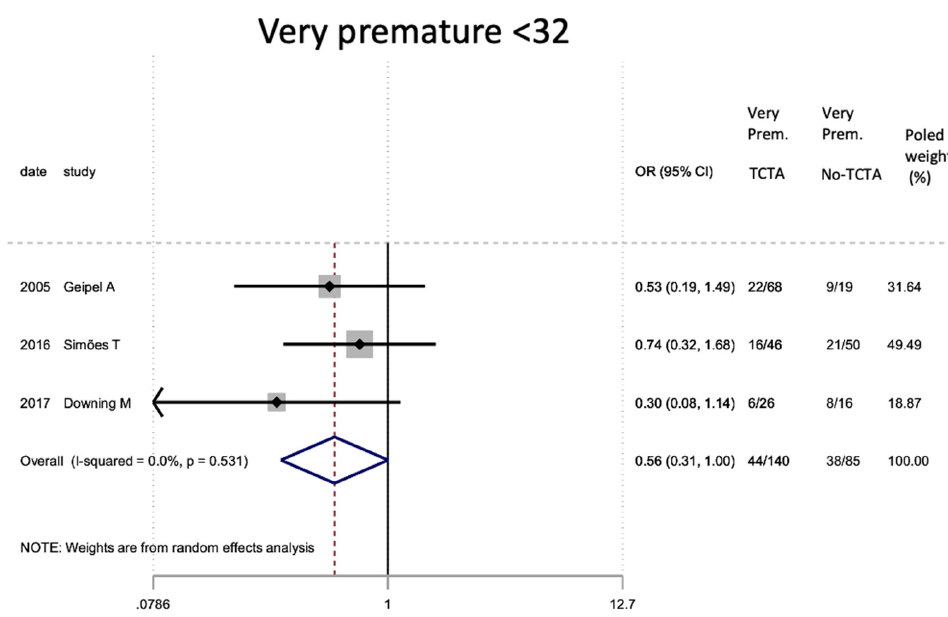
Figure 4. Results of the meta-analysis on the effect of chorionicity (TCTA vs no TCTA) on prematurity in newborns (under 37 weeks). Premat: prematurity, TCTA: tricorial-triamniotic, non-TCTA: non-tricorial-triamniotic. OR = odds ratio, CI = confidence interval.